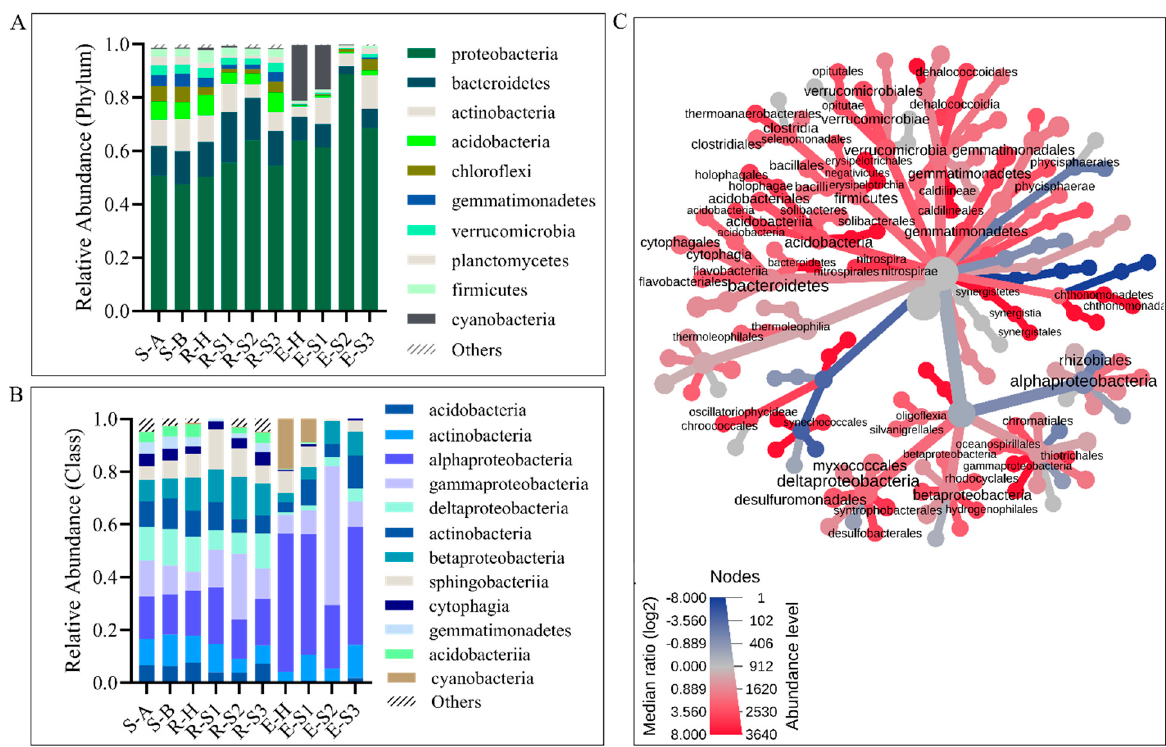
Figure 5. The effect of taproot decline disease on the soybean root microbiome. ( A , B ) The bar graphs report the relative abundance of bacterial taxa at the phylum ( A ) and class level ( B ) in bulk soil (S-A and S-B), rhizosphere (R-H, R-S1 to R-S3), and endosphere (E-H and E-S1 to E-S3) microbiomes of healthy and TRD-symptomatic soybean. Only taxa with the highest abundance are shown. ( C ) Heat tree visualization of taxonomic differences between rhizosphere and endosphere microbiomes. Blue and red indicate that corresponding taxa are lower and higher, respectively, in the rhizosphere as compared with the endosphere. The color gradient and the size of the node, edge, and label are based on the log 2 ratio of median